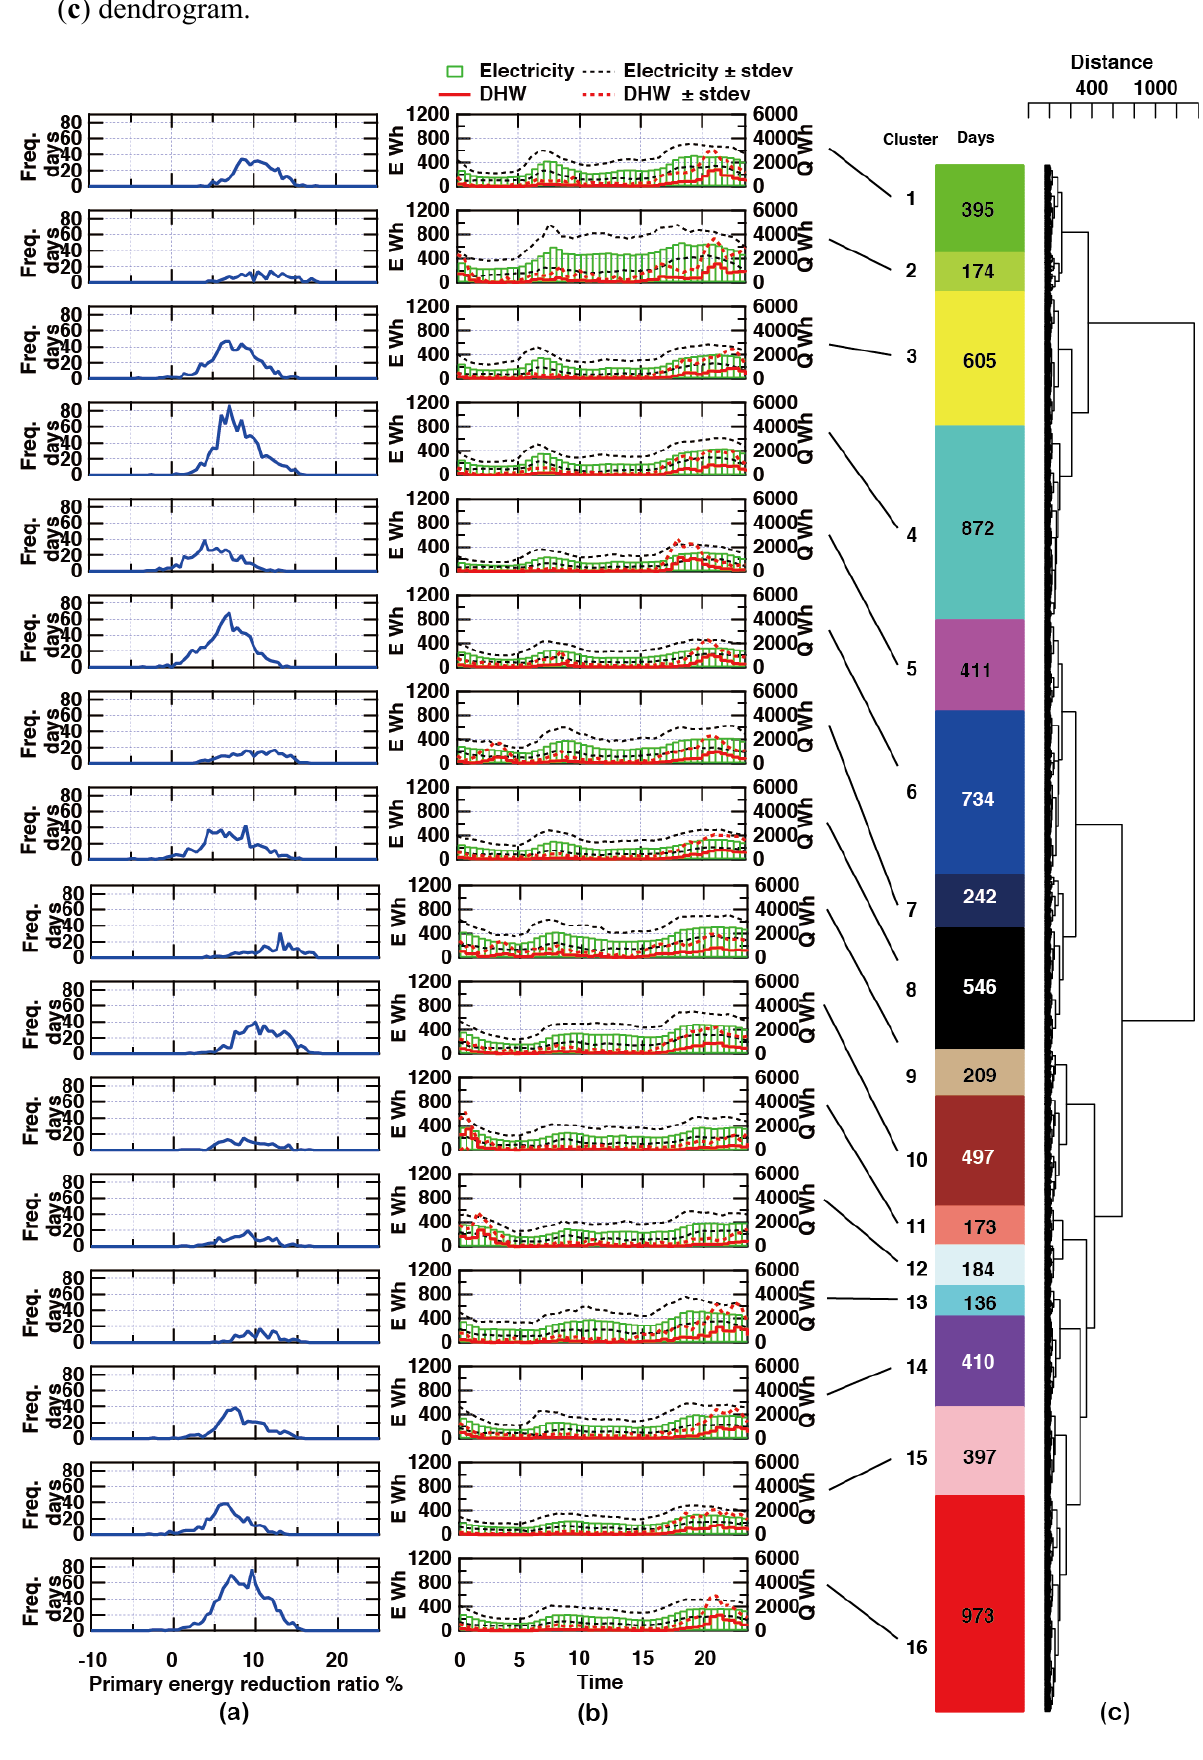
Figure 10. Clusters in Group C. ( a ) primary energy reduction ratio; ( b ) demand patterns; ( c )